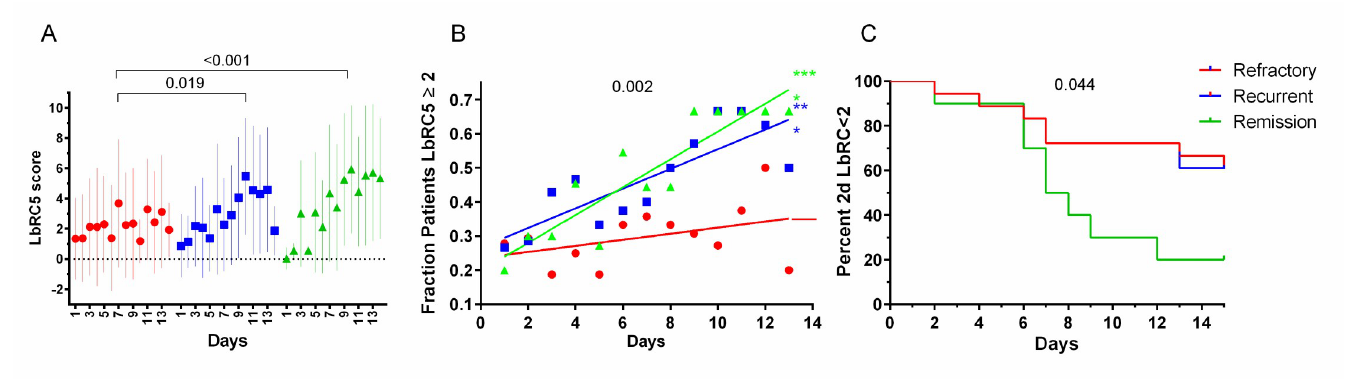
Fig 1. LbRC5 scores vary between clinical outcome groups. A. Mean LbRC5 scores among patients of refractory, recurrent, and remission outcome groups. Red samples = refractory patients. Blue samples = recurrent patients Green samples = remission patients. Data points are means of the log10 percent titers (= geometric means of the percents) with standard deviations. The P value was determined by mixed modeling for time dependent increases in remission versus recurrent scores. B. Fraction of patients in each clinical outcome group achieving LbRC5 scores � 2 per day. Linear regression analysis (lines) indicated reasonable fits to remission and recurrent data with a common slope of 0.035, significantly different than refractory data (p = 0.002). Refractory data fit poorly to its regression line, indicating scatter (slope not significantly different from zero). C. Days from treatment initiation to LbRC5 scores > 2. C. Days from initiation of treatment to sustained LbRC5 scores > 2. The first days at which LbRC5 scores were > 2 for at least 2 consecutive days were recorded as hits in this Kaplan-Meier analysis; if a patient did not achieve this, she was scored as indeterminate at day 15, the day after the interval being studied. Remission scores were significantly different (p = 0.044) by log-rank